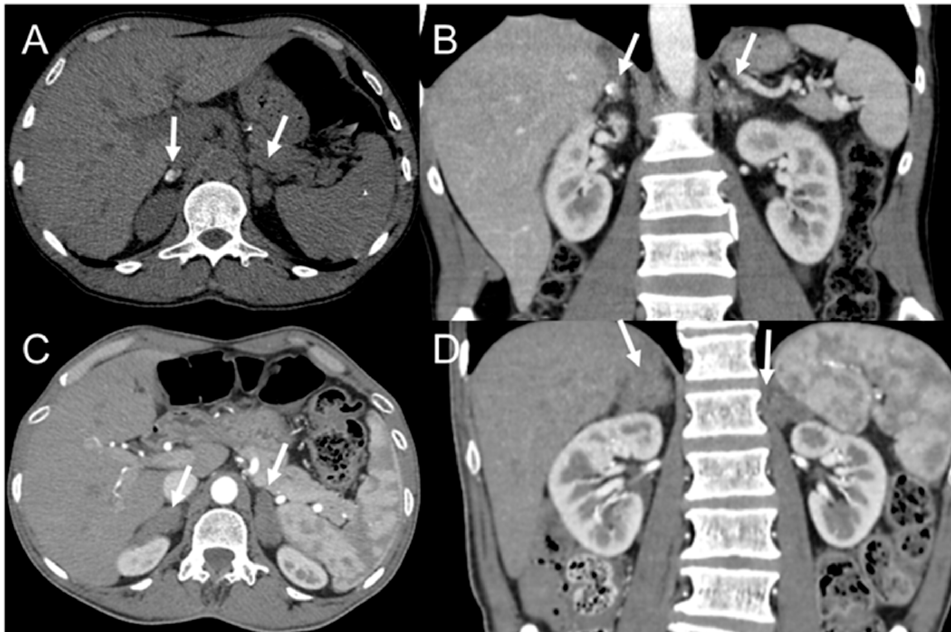
Figure 6. Computed tomography axial without contrast ( A ) and coronal post-contrast ( B ) images showing asymmetric adrenal thickening without significant contrast enhancement. The right adrenal is calcified, whereas the left is enlarged. Computed tomography axial post-contrast ( C ) and coronal post-contrast ( D ) from another patient showing adrenal thickening.